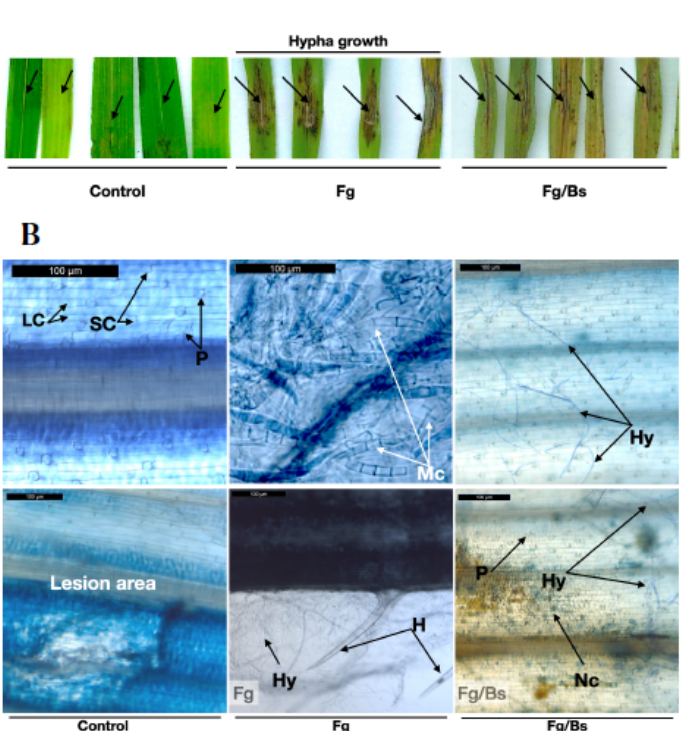
Figure 8. Detached leaves assay with Bd-21. ( A ) Bd-21 was used to assess the effect of the Bacillus Fg- K1-4 on leaves 4d post inoculation (dpi). Detached leaves from ~2 months old plants were wounded using a glass rod, sown in water agar (WA) and inoculated with Fg- K1-4. Control (treated with water only) Fg- K1-4 infection shows dark necrotic areas around the inoculation point with conspicuous development of hypha. Fg- K1-4/EU07 treatment shows fewer necrotic areas around the laceration point with some mycelia growing from this point. ( B ) Trypan blue staining of the detached leaves of Bd-21 4 dpi. Adaxial view of leaves of Bd-21 non-infected (Control), infected with Fg -K1-4 ( Fg ) and infected with Fg -K1-4 and treated with Bs (Fg/Bs) Trypan blue. LC: Long cells, SC: Short Cells, P: Papilla, H: Hair, Hy: Hypha, Mc: Macroconidia, Nc: Necrotic damage. Scale bars = 100 µm.